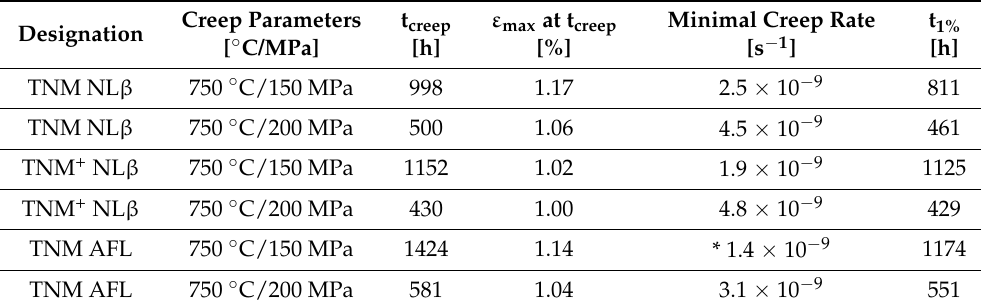
Table 4. Results of creep tests conducted on LPBF-TNM and TNM + alloys after adjustment of the indicated